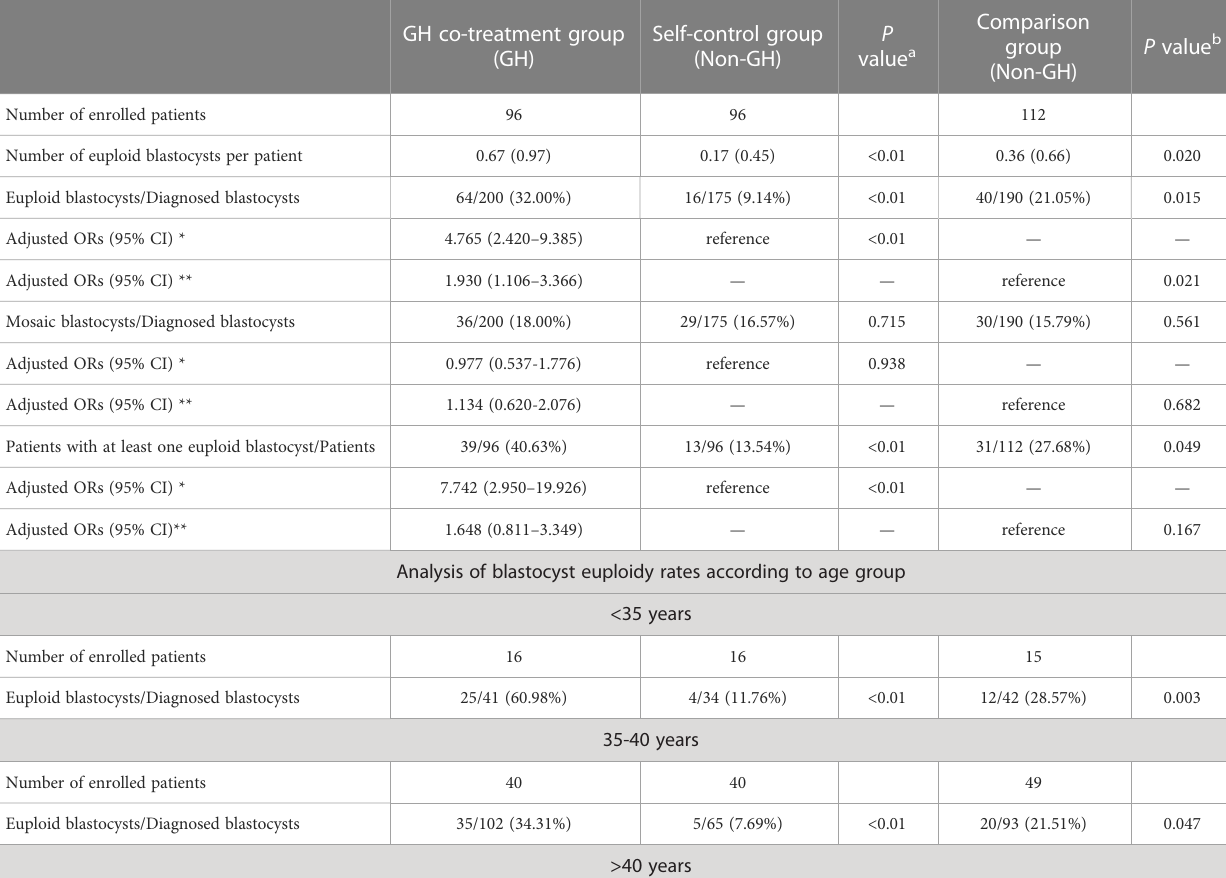
TABLE 3 Comparison of preimplantation genetic testing for aneuploidy